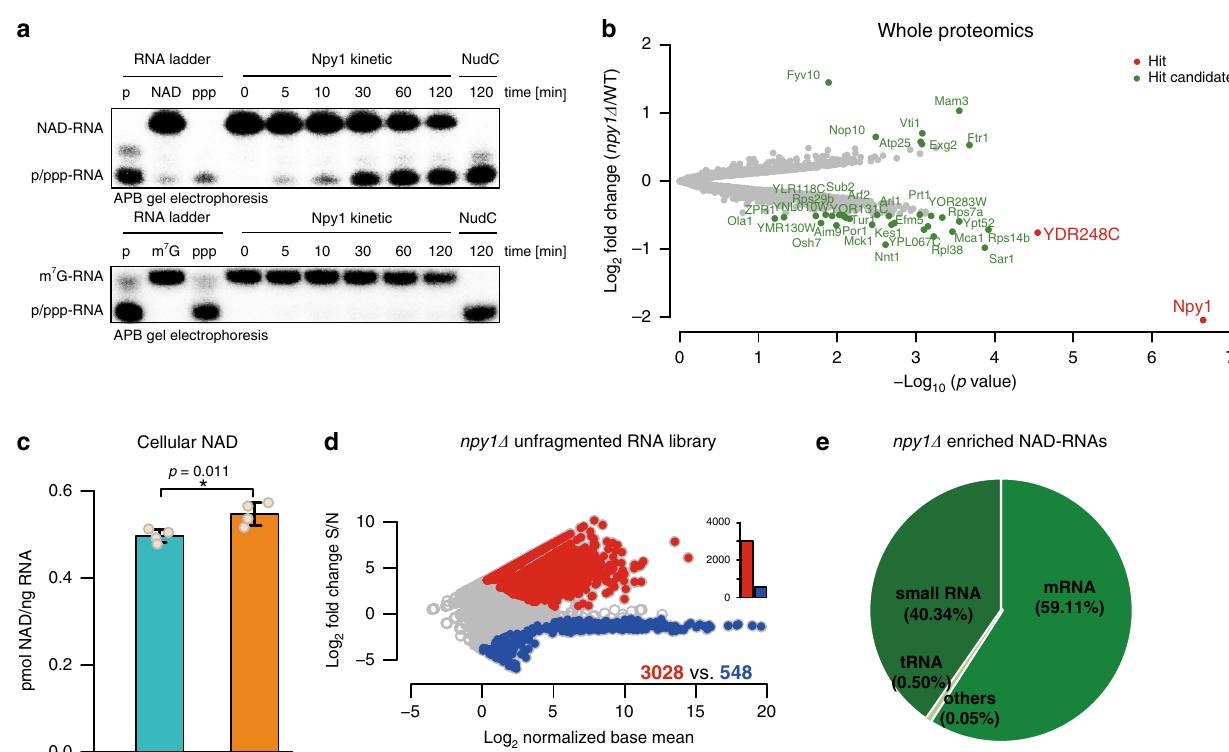
Fig. 3 Npy1 affects NAD-RNA in vitro and in vivo. a S. cerevisiae Npy1 in vitro enzyme kinetics of decapping of 5 ′ -NAD- and 5 ′ -m 7 G modi fi ed RNAs was analyzed in the presence of Mn 2 + . A α - 32 P-body-labeled 5 ′ -fragment of TDH3 RNA (98 nt) and a corresponding NAD-RNA control were treated with NudC in the presence of 2 mM Mg 2 + and 1 mM Mn 2 + , and resolved by APB gel electrophoresis. Three independent experiments were performed, n = 3. b Whole proteome analysis of cell lysates (WT strain vs . npy1 Δ ). Red dots indicate enriched hits (fold change >1.5 and FDR < 0.05), whereas green dots are hit candidates (fold change > 1.4, 0.05 ≤ FDR < 0.2) and gray dots are proteins without signi fi cant change. c Quanti fi cation of cellular NAD content in WT (blue bar) and npy1 Δ (orange bar) yeast strains, determined using an enzyme cycling assay. The amount of NAD was normalized to the amount of total RNA determined in cell lysates, obtained from each sample. Error bars represent the mean ± SD. Performed in biologically independent replicates, n = 4. p -values are denoted by asterisks: * p < 0.05 (Student ’ s t -test, one-sided). d Enriched NAD-RNAs in the unfragmented NAD captureSeq library of the Npy1 depletion ( npy1 Δ ) strain. Performed in biologically independent replicates, n = 3. e Reads of enriched NAD-RNA in the npy1 Δ unfragmented